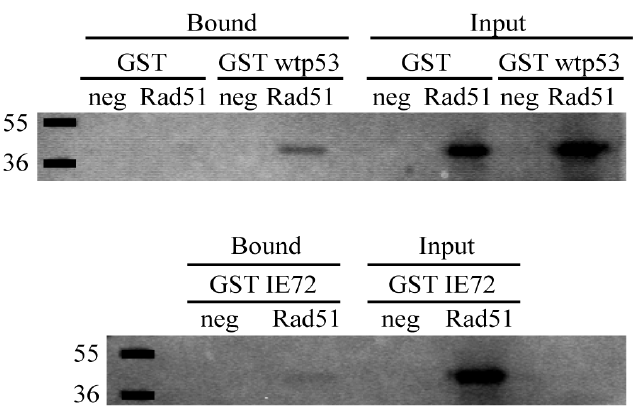
Figure 4. GST pulldown experiments revealed IE72 and wt p53 bound to Rad51. GST proteins were incubated with radiolabeled Rad51 for 1 h as described in experimental details. Input lanes represent 1/10th the total starting reaction. Negative